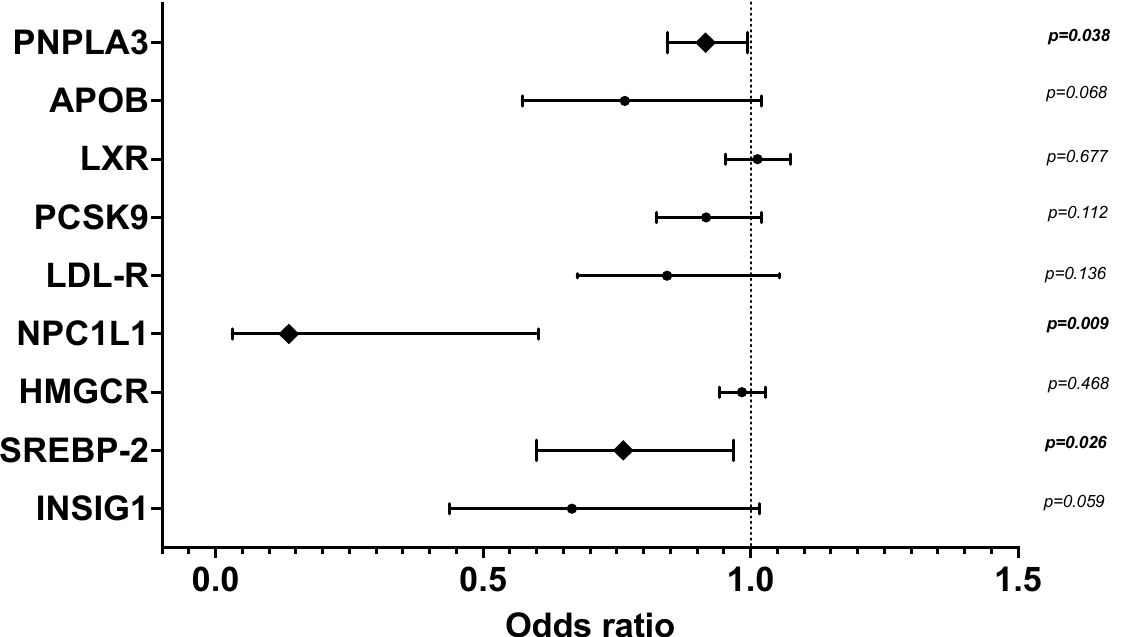
Figure 4. Multivariate binary logistic regression of liver graft mRNA gene expression of selected proteins involved in lipid metabolism, for the presence of predominant Ld-MaS compared to nil-Steatosis. The 9 genes are listed on the y-axis, and the odds ratio with 95% confidence interval is shown on the x-axis. Data were adjusted for donor age, BMI and traumatic cause of death. APOB: apolipoprotein B; PNPLA3: Patatin-like phospholipase domain protein 3; HMGCR: 3-hydroxyl-3-methylglutaryl coenzyme A reductase; INSIG-1: insulin-induced gene 1; LDLR: LDL receptor; LXR: Liver X receptor; NPC1L1: Niemann-Pick C1-Like 1; PCSK9: Proprotein convertase subtilisin/kexin type 9; SREBP-2: sterol regulatory element-binding protein 2. The diamond symbol indicates the significant variables. p -values numbers marked in bold indicate numbers that are significant at the p < 0.05 level